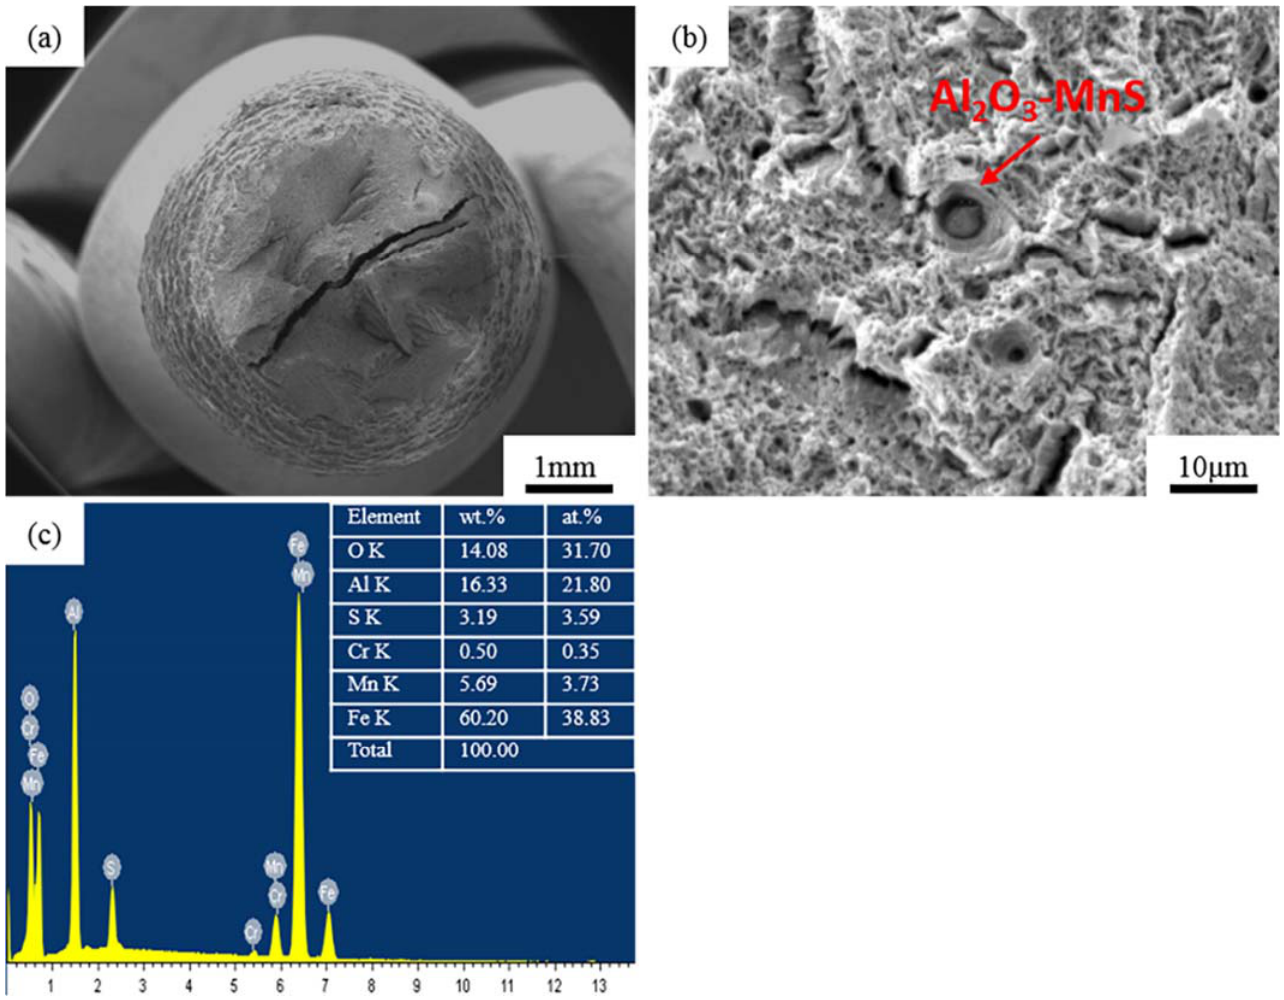
Figure 7. SEM images of the fracture surfaces of Al ‐ Steel after NACE ‐ A. ( a ) Fracture morphology at low magnification; ( b ) inclusion on fracture surface; ( c ) EDS of inclusion of Al ‐ Steel.